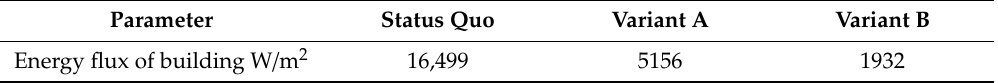
Table 3. Energy flux for Elief Playhouse Antwerp scenarios on a typical hot summer day (21.07).